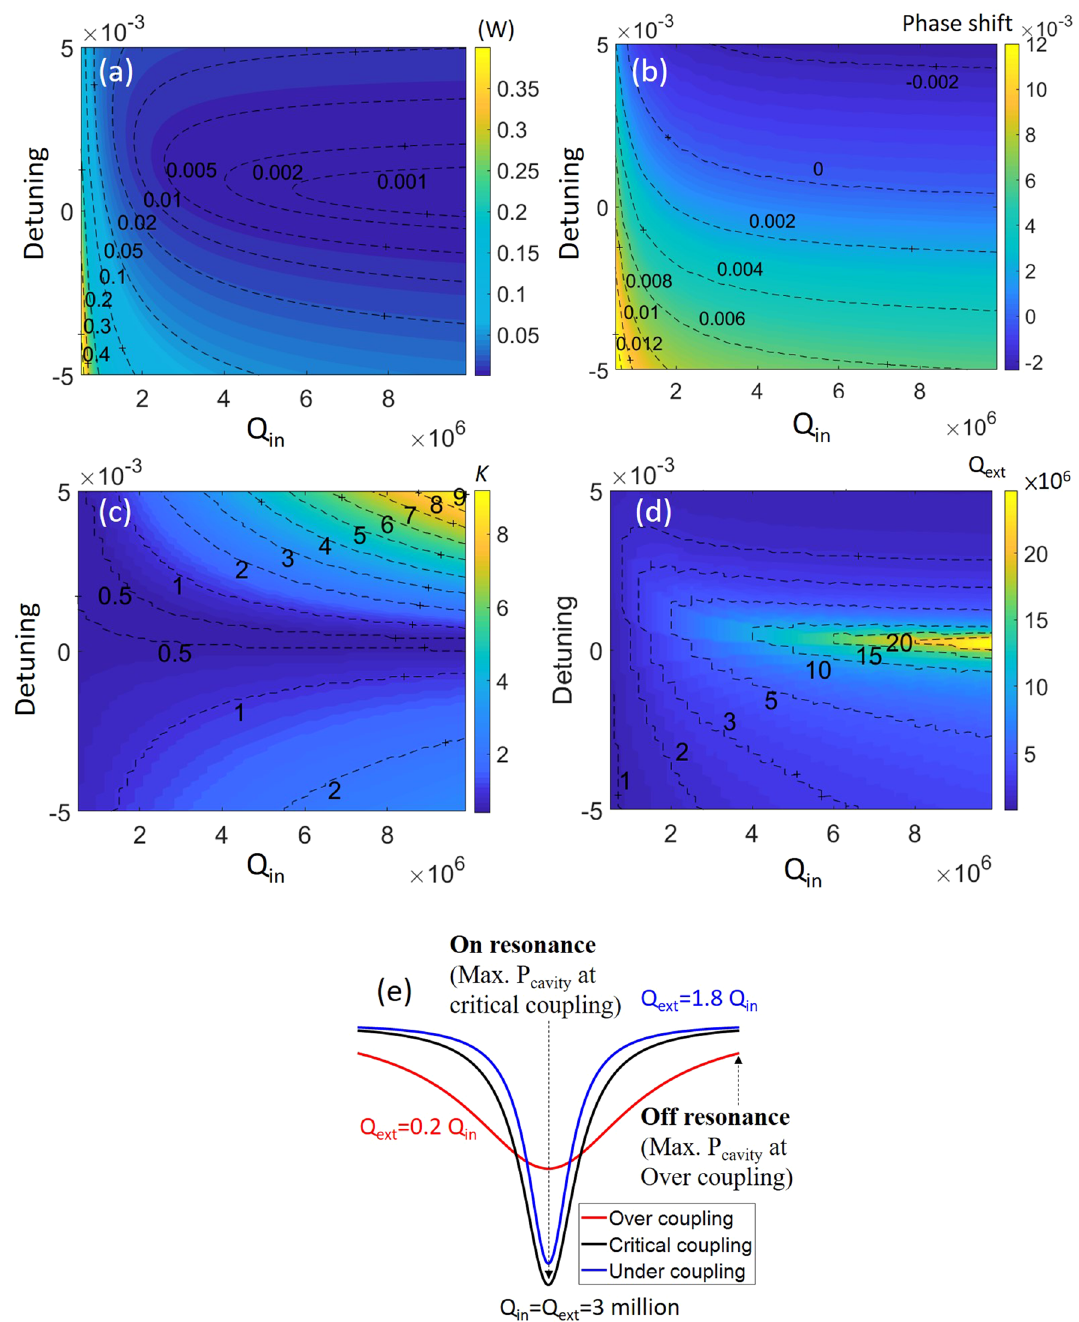
Figure 3. Results showing the prediction of ( a ) the threshold power, ( b ) the phase shift, ( c ) the coupling factor K , and ( d ) the external quality factor Q ext from the traveling wave theory. ( e ) The schematic illustration of cavity resonances at different